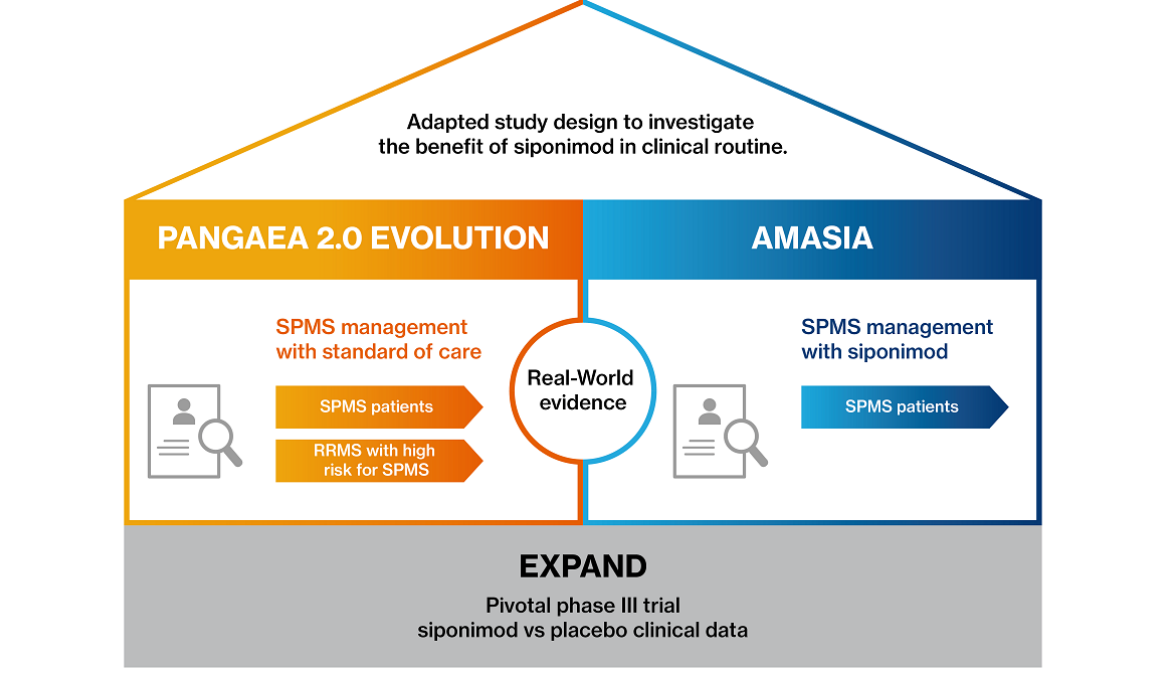
Figure 1. AMASIA within the study framework of siponimod studies. AMASIA: imp A ct of M ayzent [siponimod] on second A ry progressive multiple S clerosis patients in a long-term non- I nterventional study in Germ A ny; EXPAND: EXploring the efficacy and safety of siponimod in PAtients with secoNDary progressive multiple sclerosis [29]; RRMS: relapsing remitting multiple sclerosis; SPMS: secondary progressive multiple